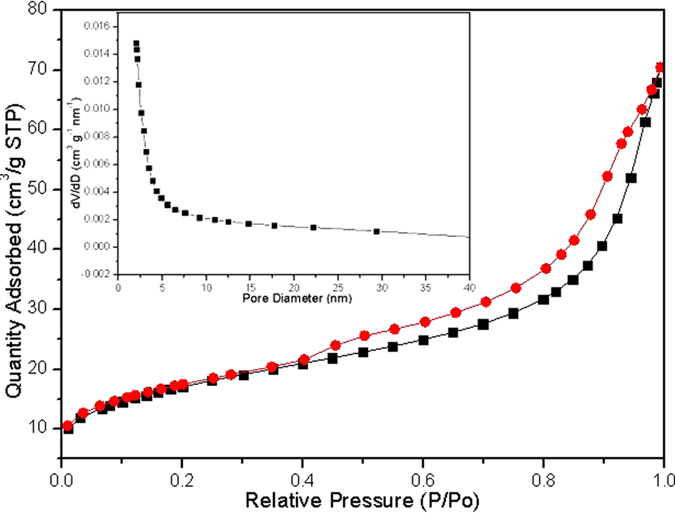
Nitrogen adsorption-desorption isotherm and Barrett-Joyner-Halenda (BJH) pore size distribution plot (inset) of the prepared hollow SnO2@TiO2 nanocapsules.